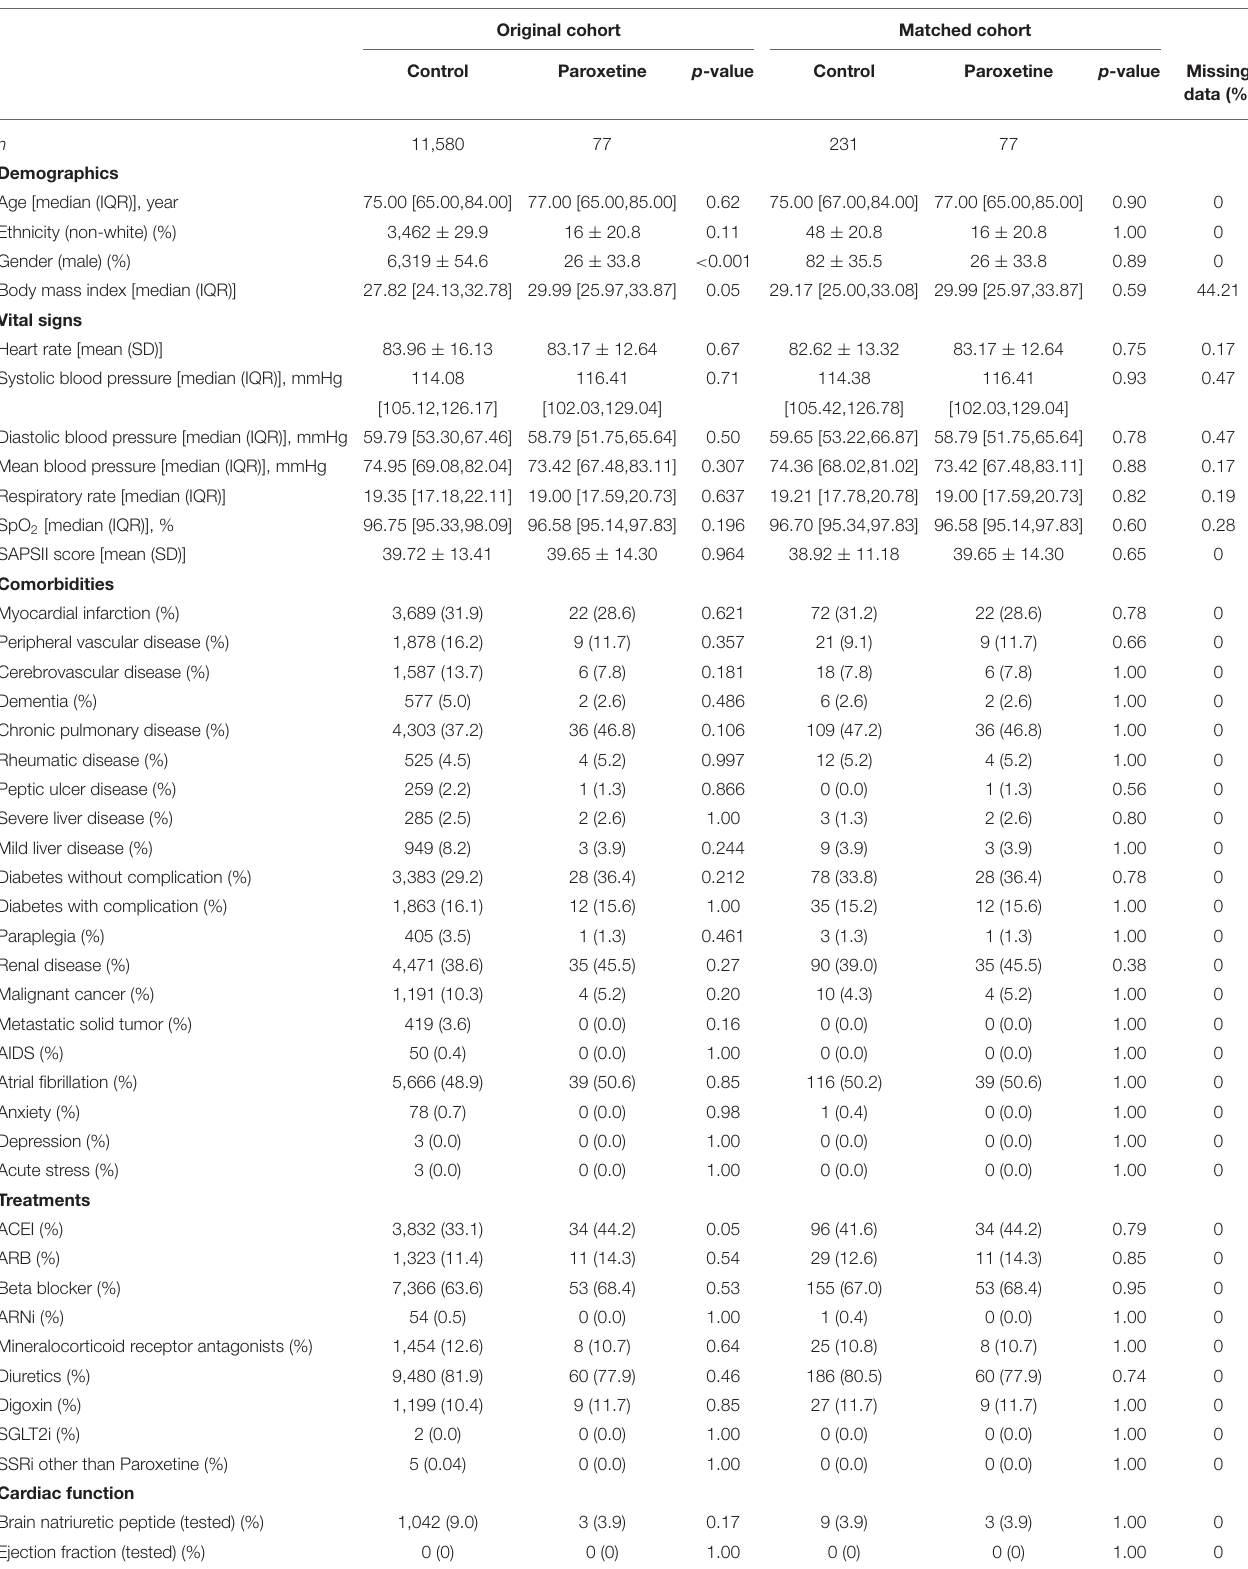
TABLE 1 | Comparison of the original cohort and the matched cohort. Original cohort Matched cohort Control Paroxetine p -value Control Paroxetine p -value Missing